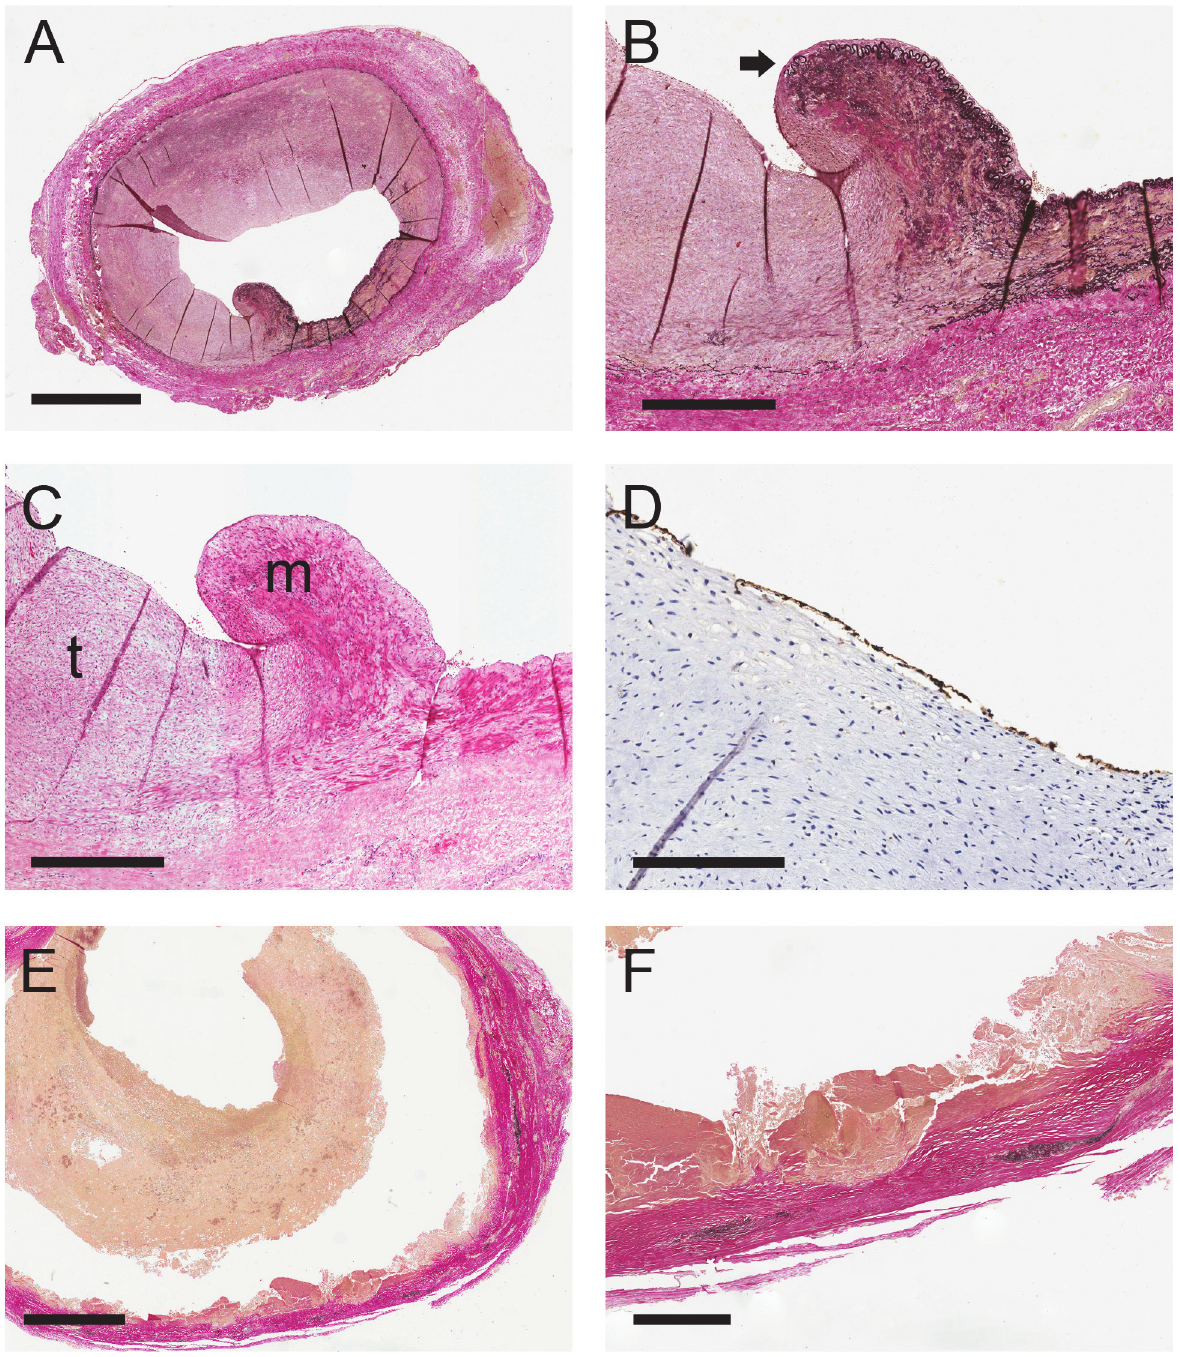
Fig 3. Histology of carotid aneurysms. A-D, dissection; E and F, degeneration. A, overview of aneurysm due to dissection. Elastin-van Giesson (EvG) stain. Bar = 1.5 mm. B, higher magnification of the same staining as A. Arrow indicates the disrupted internal elastic lamina. Bar = 500 μ m. C, Hematoxylin and eosin staining of the same panel as B. m, media; t, organized thrombus that replaces the absent media. Bar = 500 μ m. D, CD34 immunostain showing endothelial coverage of the thrombus (in brown). Bar = 250 μ m. E, overview of an aneurysm due to degeneration. Elastin-van Giesson (EvG) stain. Bar = 4 mm. F, higher magnification of the same staining as E. In black remnants of the elastic fibers of the media. Bar = 1 mm.